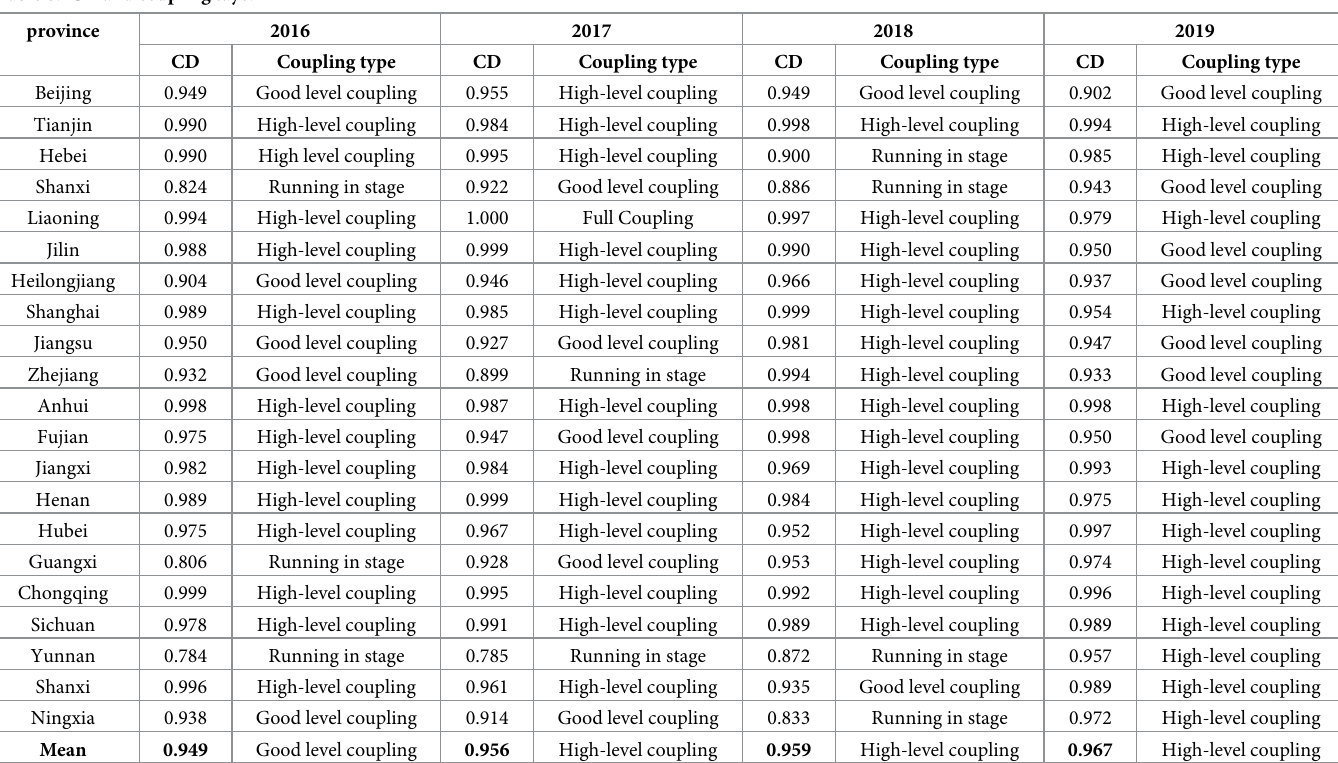
Table 8. CD and coupling